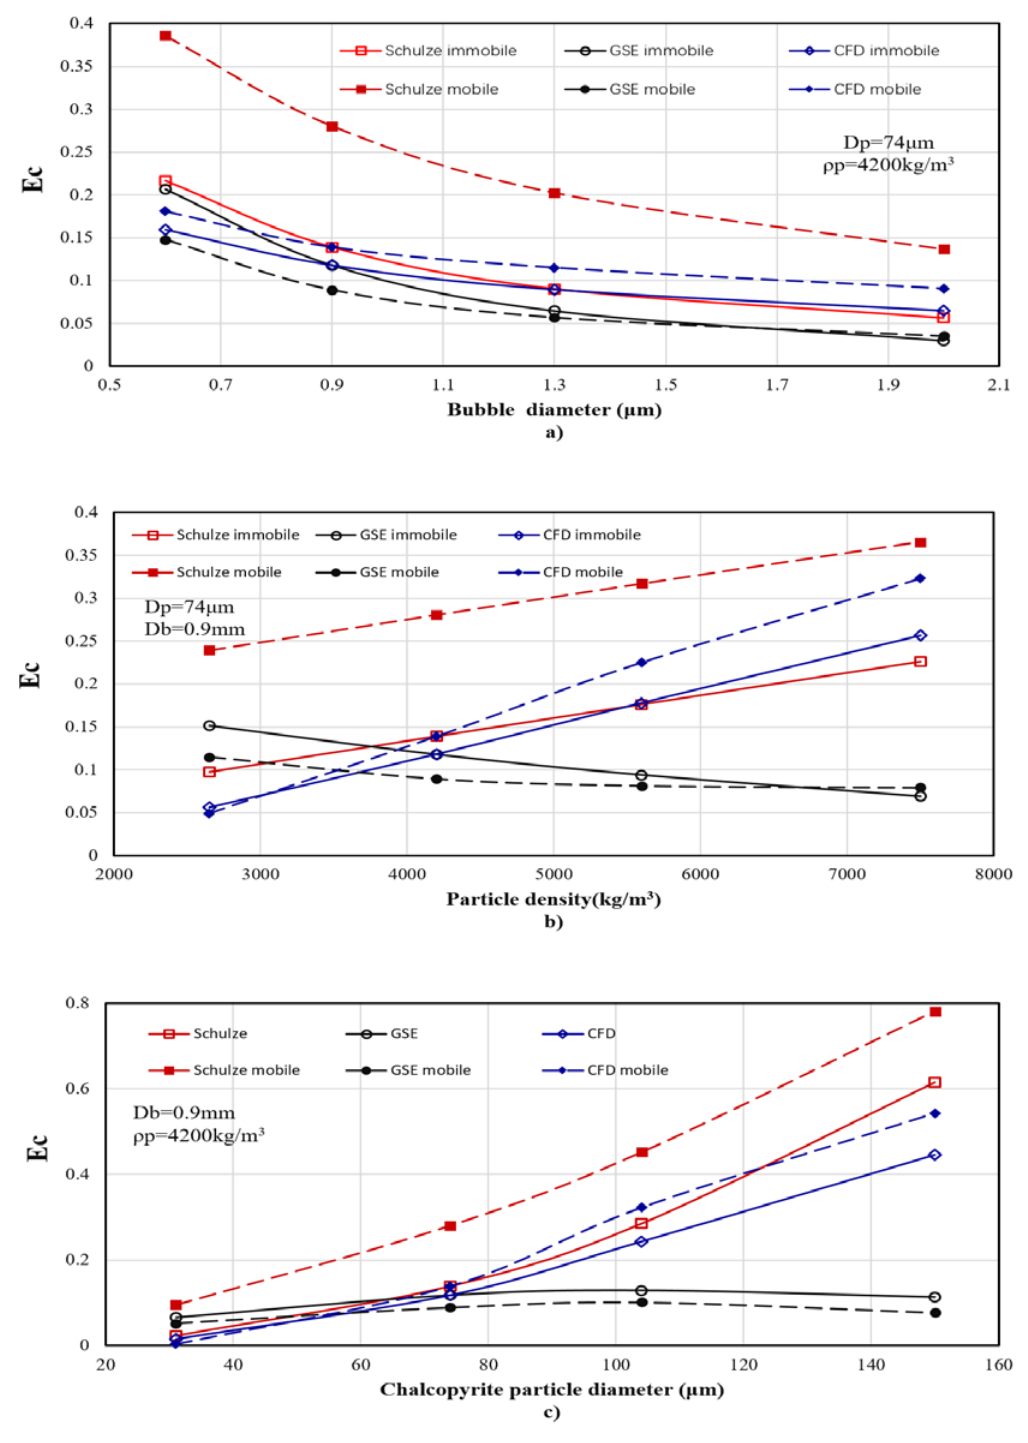
Figure 10. Comparison of the e ff ect of ( a ) bubble diameter ( D b ), ( b ) particle density ( ρ p ), and ( c ) particle diameter ( D p ) respectively, on Schulze, GSE, and CFD predictions for collision efficiency.